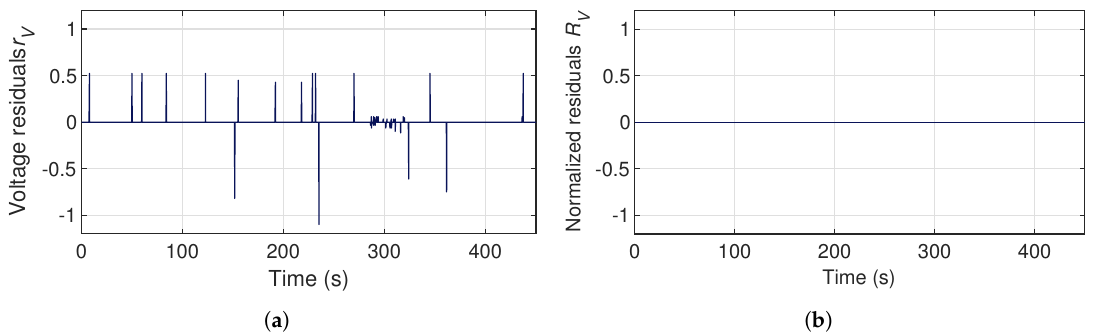
Figure 12. Profile of the residuals r V and R V during normal operation scenario: ( a ) raw residuals r V , ( b ) normalized residuals R V